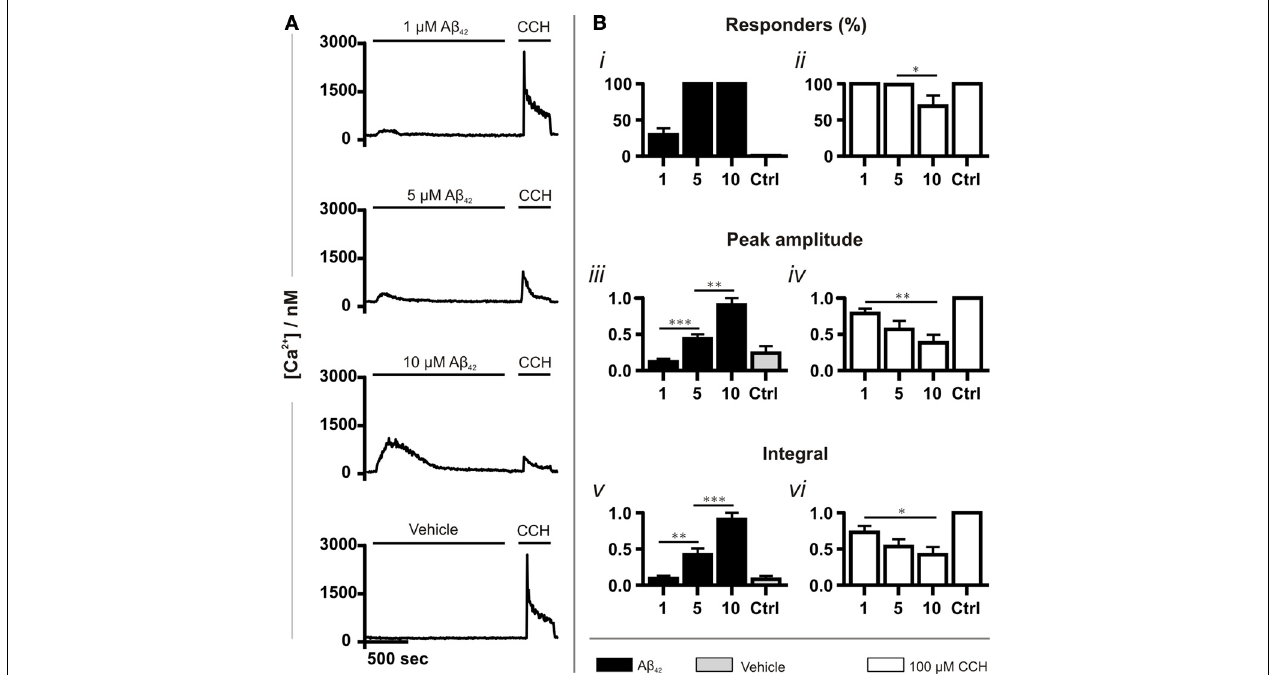
dd H 2 O and CCH is presented as (Bi,ii) percentage of responding cells, (Biii,iv) peak amplitude and (Bv,vi) integral of the response. A β 42 oligomer-induced Ca 2 + transients were normalized to the responses induced with the highest concentration (10 μ M) of the respective A β 42 preparation. CCH-induced Ca 2 + responses were normalized to control experiments conducted on the same experimental day. Bar graphs are mean ± SEM from at least three independent experiments. ∗ p < 0 . 05; ∗∗ p < 0 . 01; ∗∗∗ p < 0 . 001.